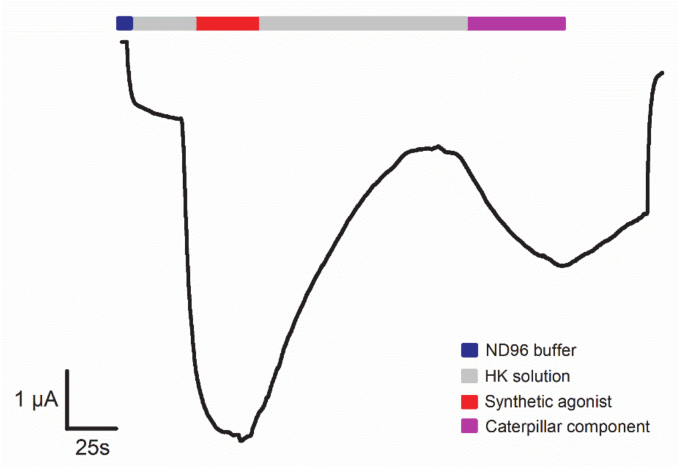
Figure 3. Electrophysiology-based bioassay with a two-electrode voltage clamp technique, as measured in Xenopus laevis oocytes. Shown is a validation trace experiment where a G-protein coupled receptor (GPCR) is coupled to an effector channel, an inward rectifier potassium channel via a G i / o cascade. Currents were induced by exchanging a control saline low potassium solution (ND96 buffer = blue) with a measuring solution with elevated potassium (HK solution = grey). The trace reveals the agonistic activity of a bioactive component originating from a caterpillar (pink). A synthetic agonist was used as